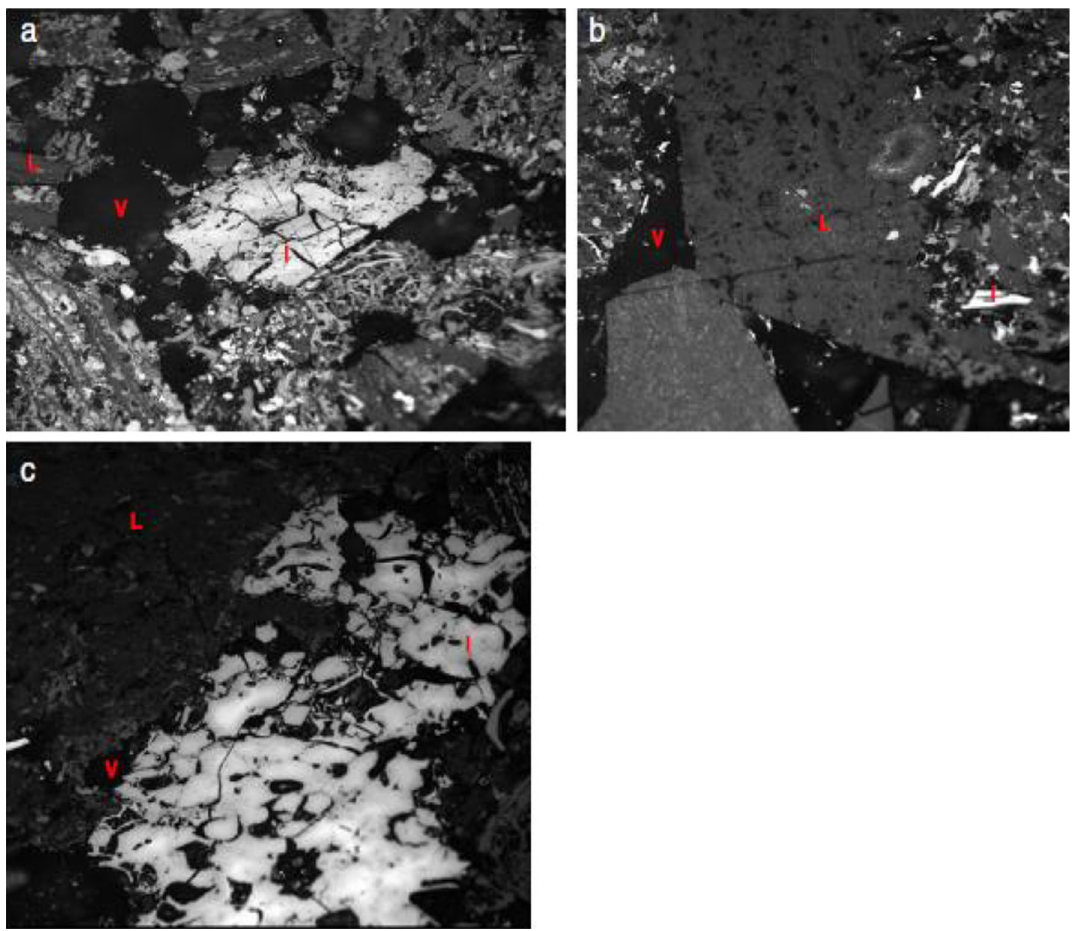
Fig. 22 Photomicrograph of coal sample a MG1D, b MG1W and c MG2H. (Liptinite shows grayish colouration, vitrinite is dark coloured, and inertinite is white under reflected light. V: vitrinite, I: inertinite, L: